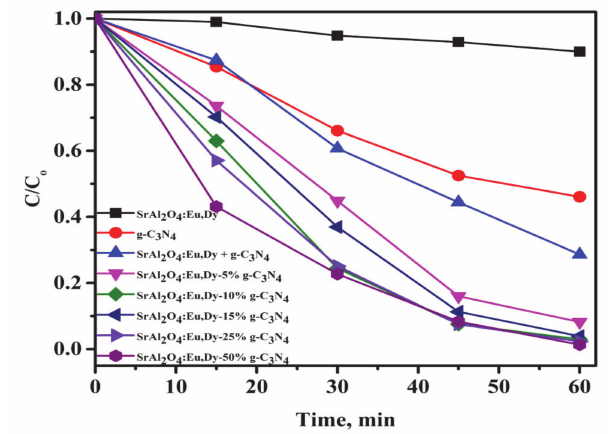
Figure 7. The photodegradation e ffi ciency of MB solution for SrAl 2 O 4 :Eu,Dy / g-C 3 N 4 hybrid composites under visible light solar illumination. Where (SrAl 2 O 4 :Eu,Dy + g-C 3 N 4 ) is physically mixed at 1:1 wt.% ratio).